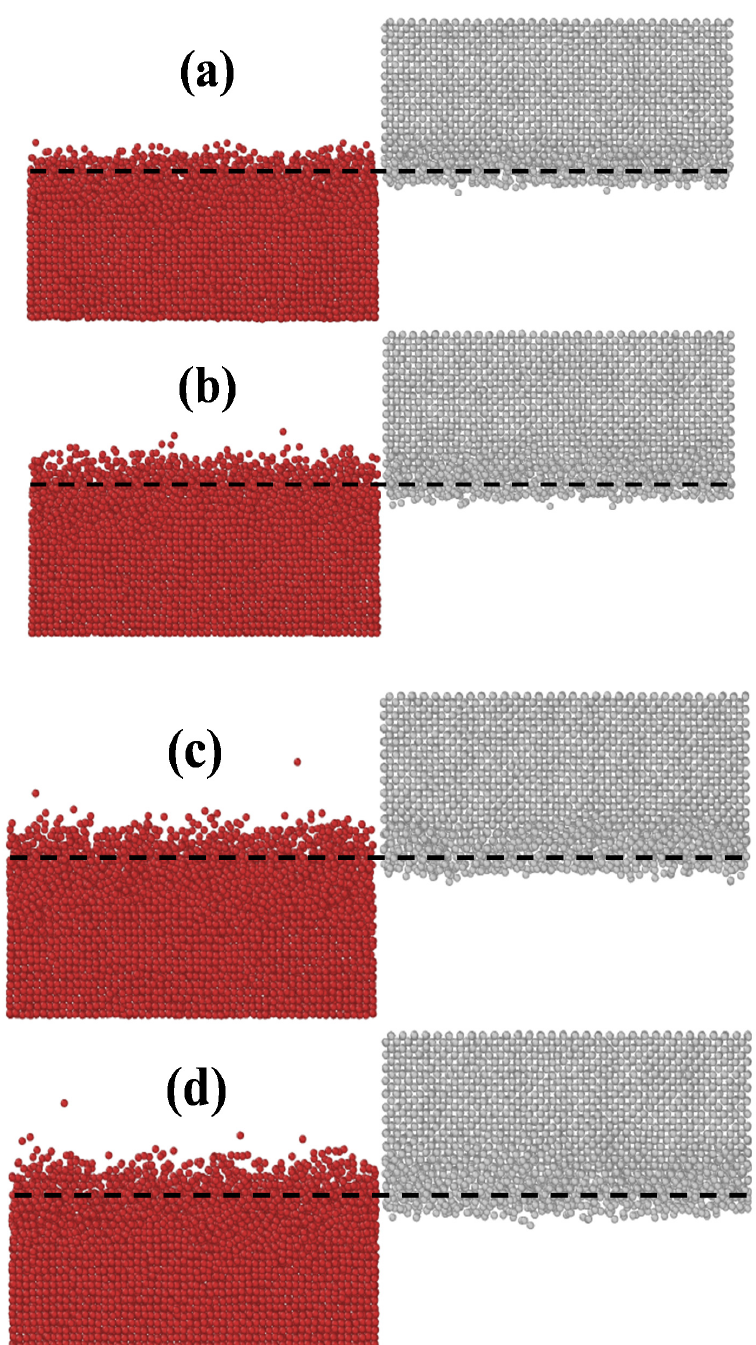
Figure 3. W/Cu interfacial structures obtained through alloying at a temperature of 1200 K for different times: ( a ) 0.2 ns, ( b ) 1 ns, ( c ) 2 ns, and ( d ) 4 ns. The red and gray atoms represent Cu and W atoms, respectively. These results are obtained from MD simulations using the new W-Cu potential. MD simulations of the W-Cu direct alloying process using the new W-Cu potential were carried out in this paper. During the simulations, the alloying temperatures were set